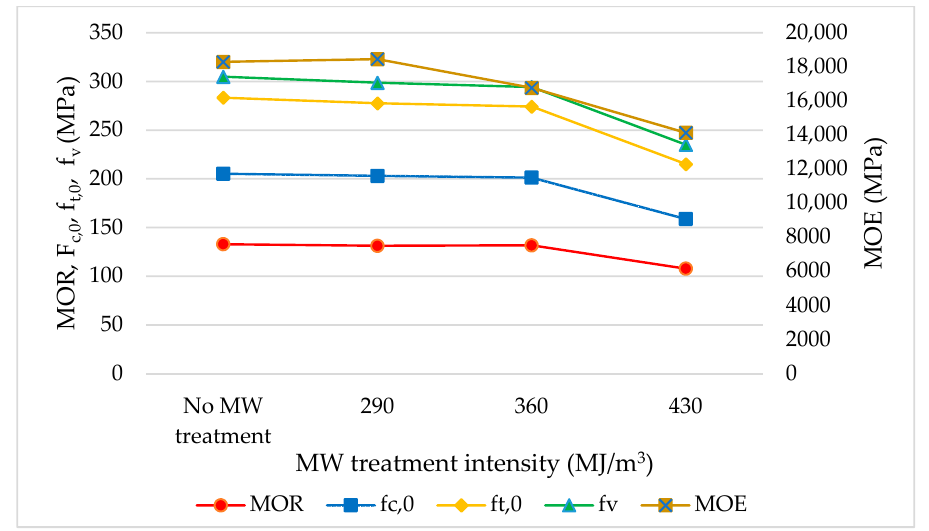
Figure 5. Relationship between mechanical properties and MW treatment intensity for 30% MC found by [7].